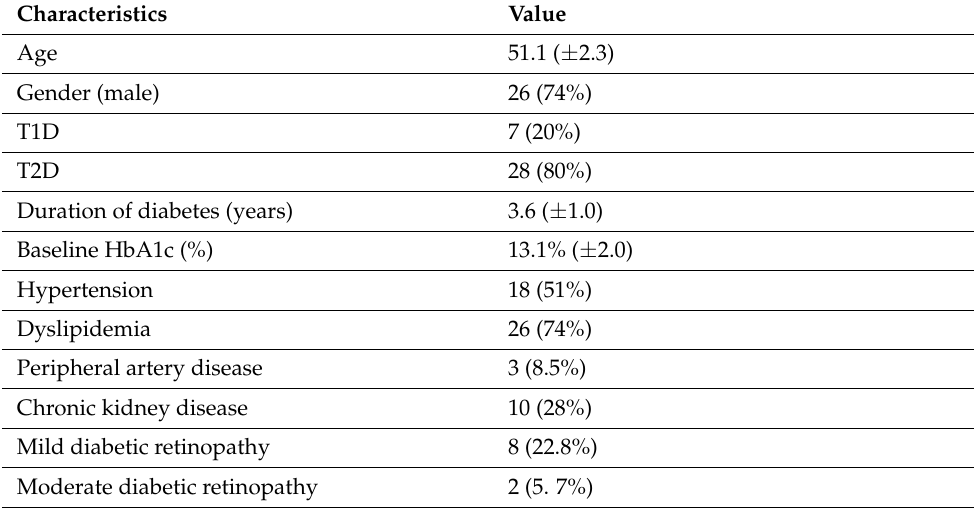
Table 1. Initial (baseline) characteristics of the diabetic patients.